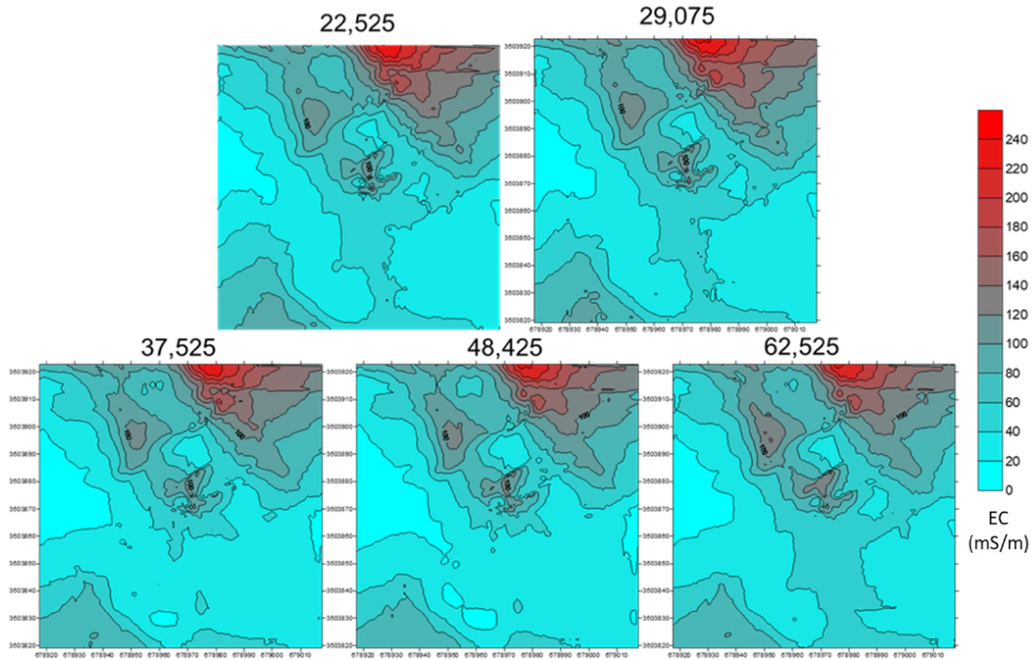
Figure 4. FDEM frequency results from Beit Nir site in active corral: 22,525 Hz, 29,075 Hz, 37,525 Hz, 48,425 Hz and 62,525 Hz.